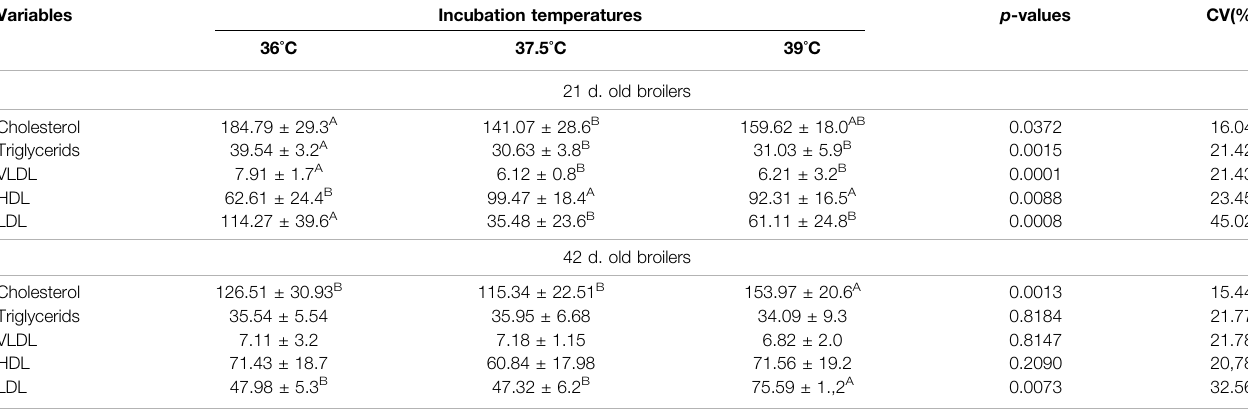
TABLE 1 | Blood lipid pro fi le of male broilers at day 21 and 42 of age, according to incubation